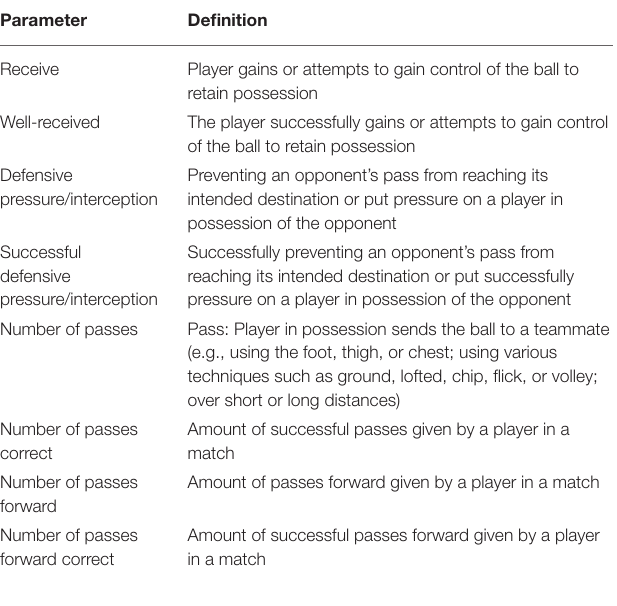
TABLE 1 | Definition of parameters used for the rating of game performance.